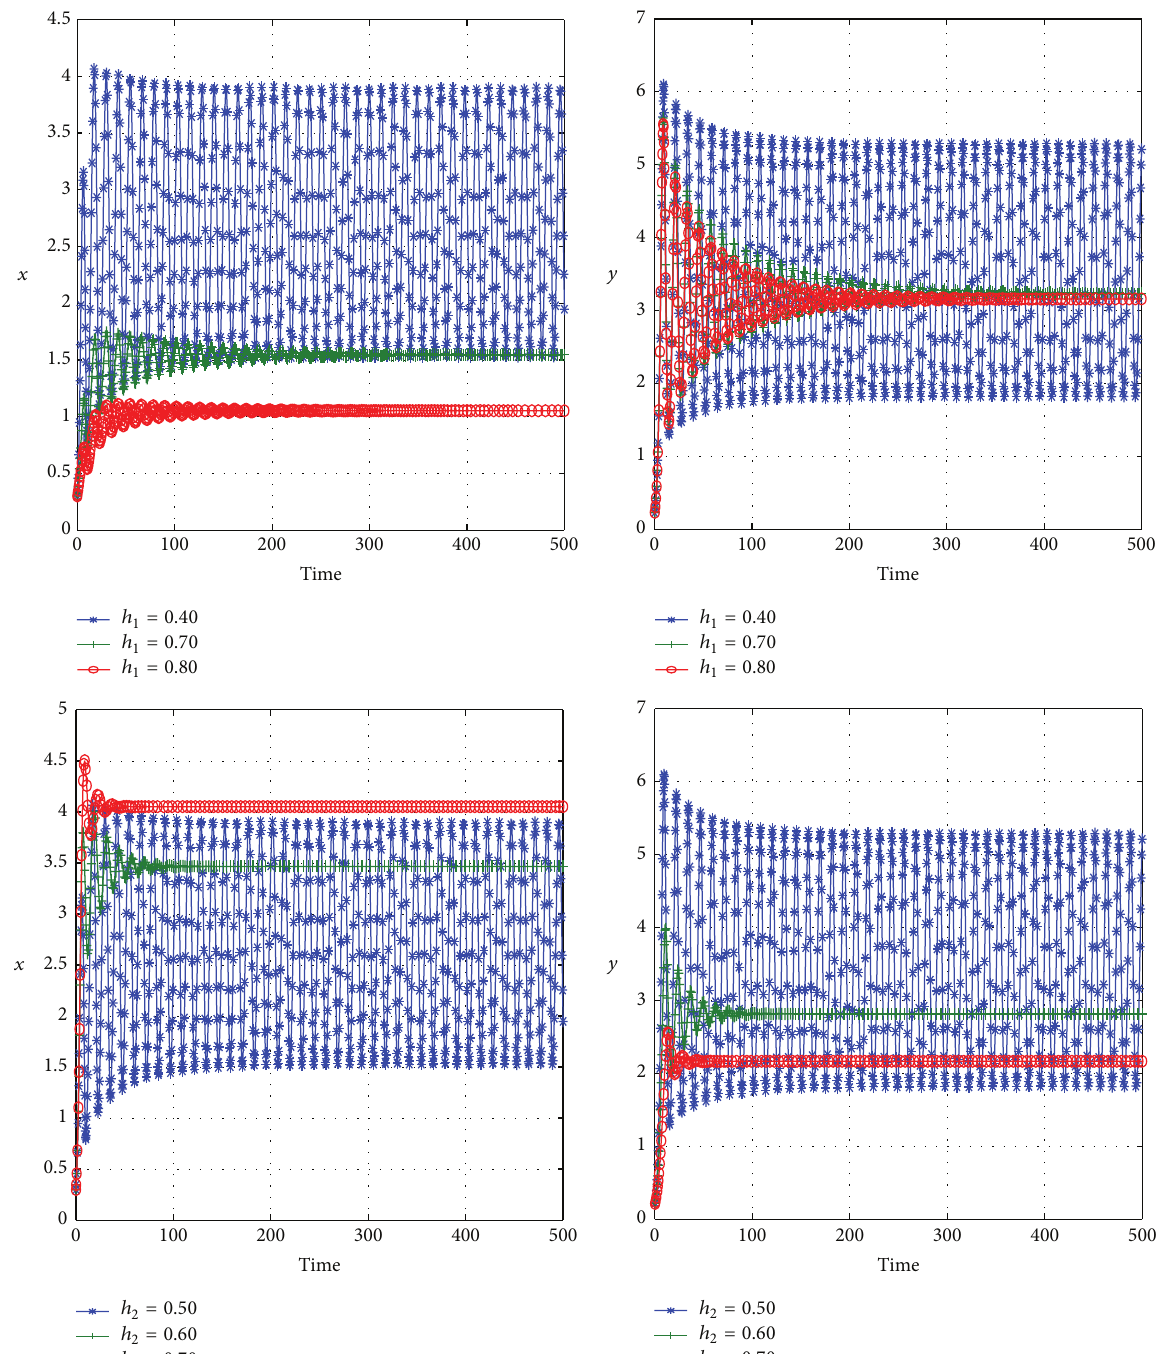
Figure 6: When 𝜏 = 2.9 > 𝜏 0 ≈ 2.8015 and ℎ 1 increases, prey species 𝑥 and predator species 𝑦 become stable; when ℎ 2 increases, prey species 𝑥 and predator species 𝑦 also become